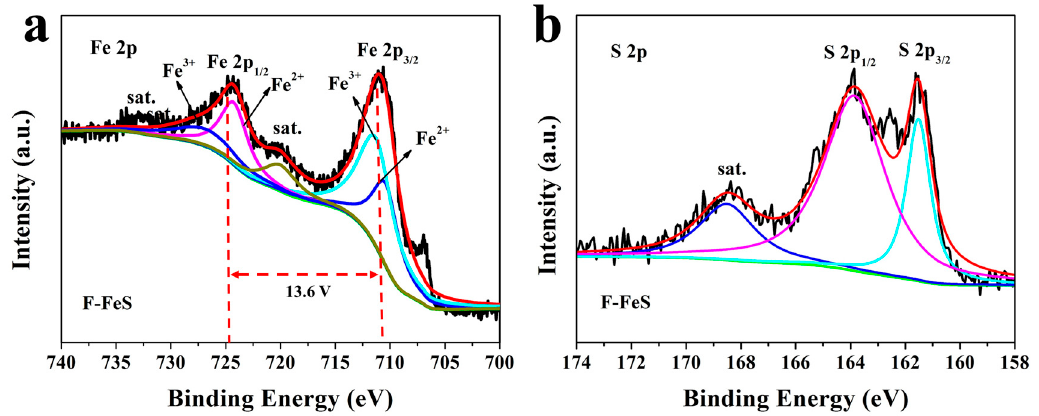
Figure 5. XPS spectra for the as-prepared 3D F-FeS nanostructure: ( a ) Fe 2p and ( b ) S 2p spectra.